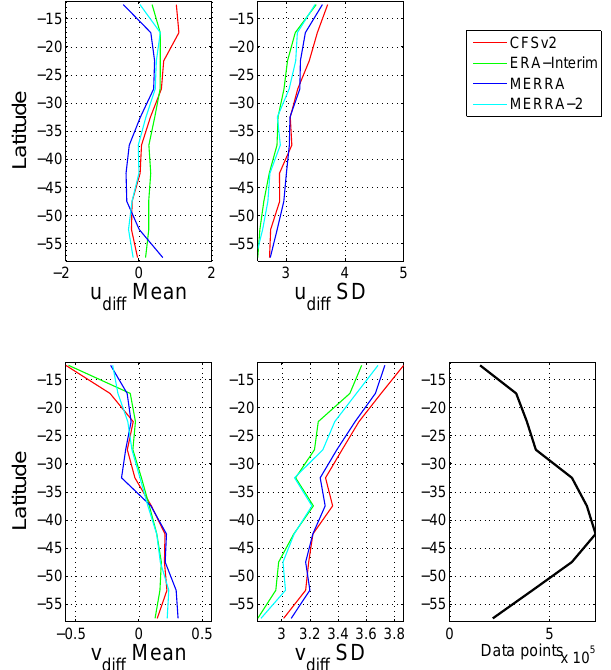
Figure 4. Zonal and meridional wind differences binned by latitude, in 1 ◦ steps. There is a clear tendency for wind difference standard deviations to be larger near the equator. There also seems to be a trend in the meridional wind differences, with net over (under) esti- mation poleward (equatorward) of 40 ◦